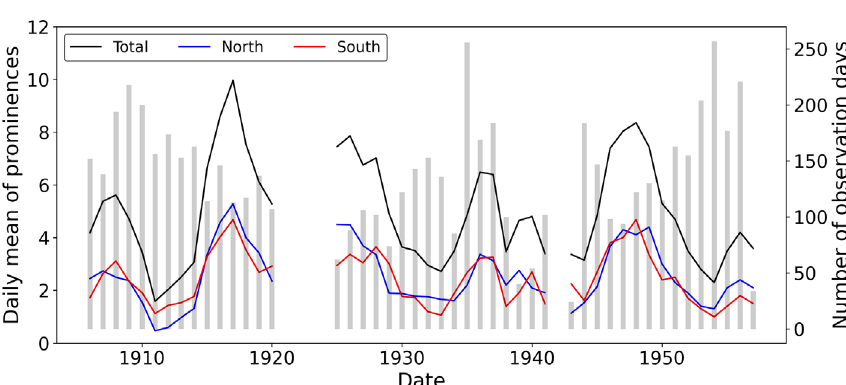
Figure 2. Daily mean of the number of prominences recorded at the Madrid Astronomical Observatory for the period 1906 – 1957. The total, north, and south number are represented by black, blue, and red lines, respectively. The annual number of observation days is depicted by gray